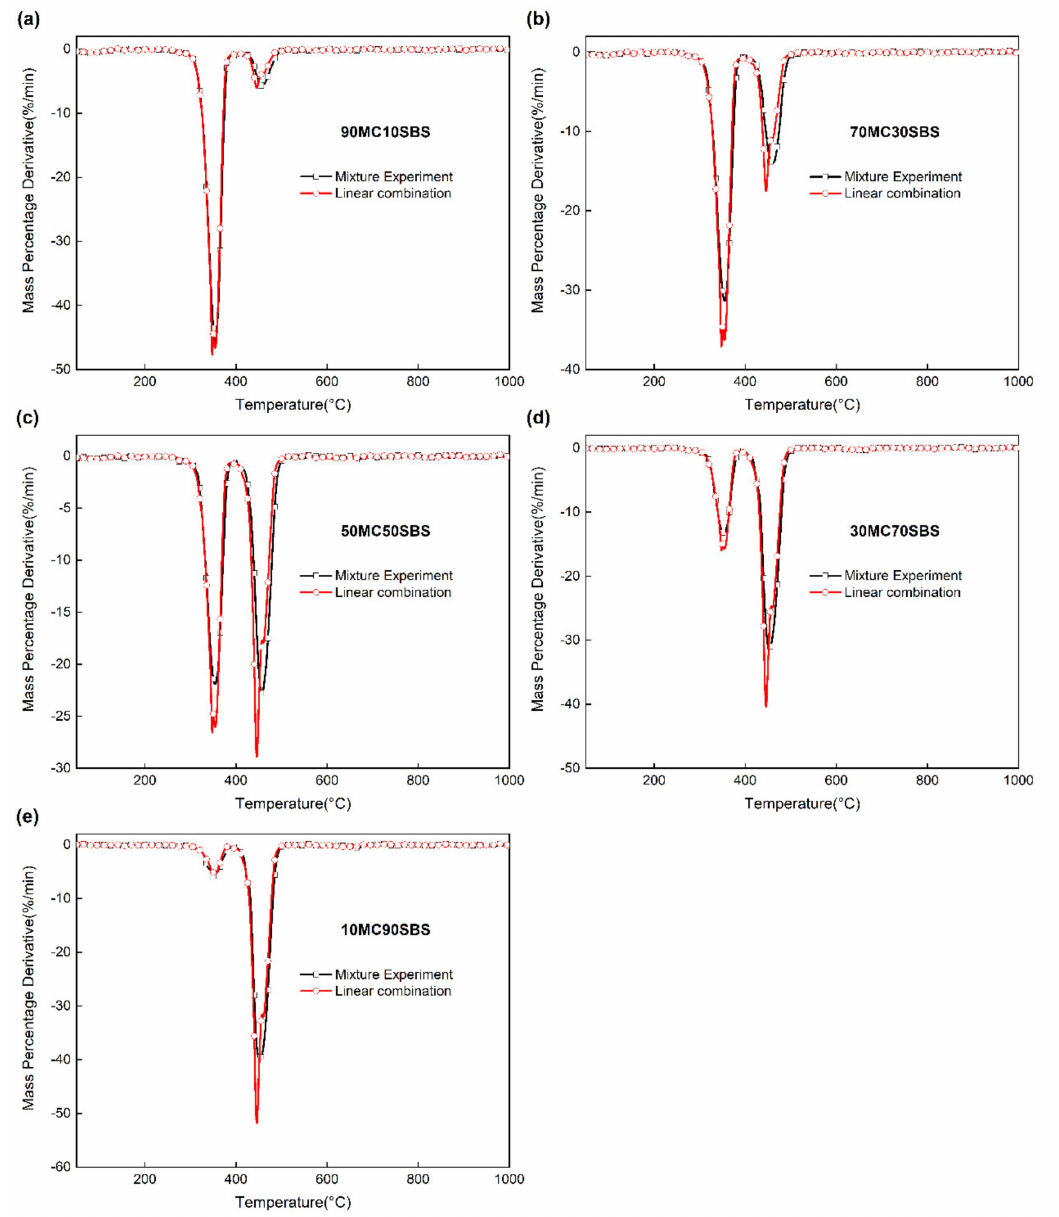
Figure 4. The DTG comparison of mixture experiments and linear combinations of pyrolysis of samples with different mixing ratios. ( a ) Mixture of 90% MC and 10% SBS (90MC10SBS); ( b ) mixture of 70% MC and 30% SBS (70MC30SBS); ( c ) mixture of 50% MC and 50% SBS (50MC50SBS); ( d ) mixture of 30% MC and 70% SBS (30MC70SBS); ( e ) mixture of 10% MC and 90% SBS